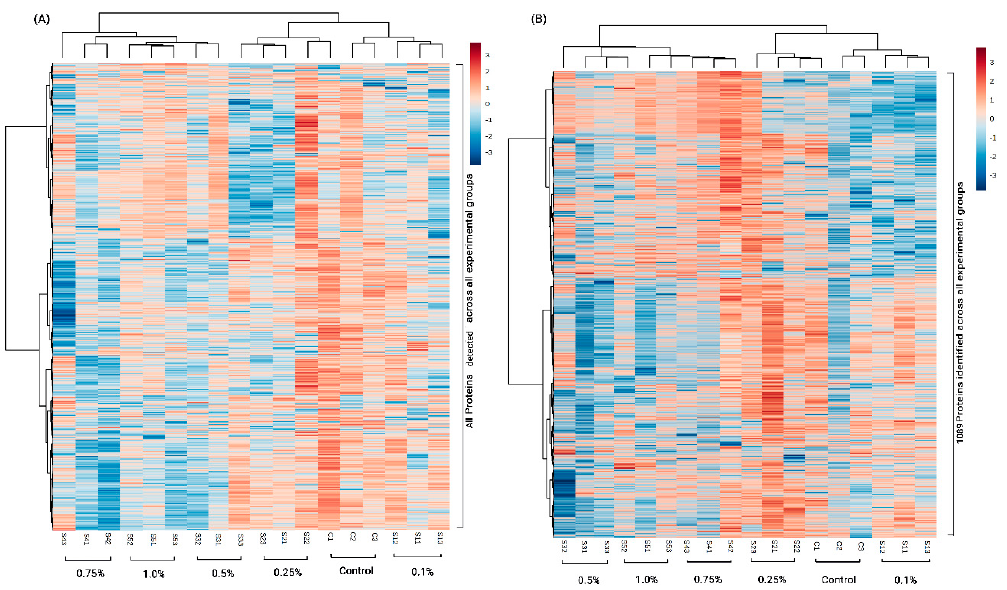
Figure 3. Heat maps plotting the relative abundances of ( A ) all detected 1715 proteins and ( B ) 1089 identified proteins across the treatment groups. C indicates control. S1–S5 indicate dietary